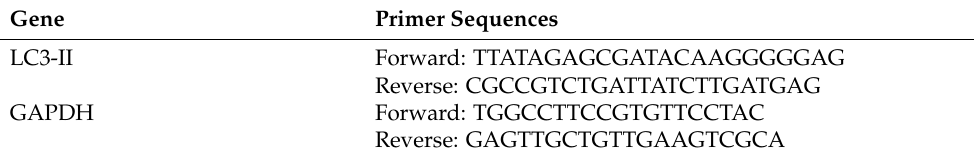
Table 1. Cont. Gene Primer